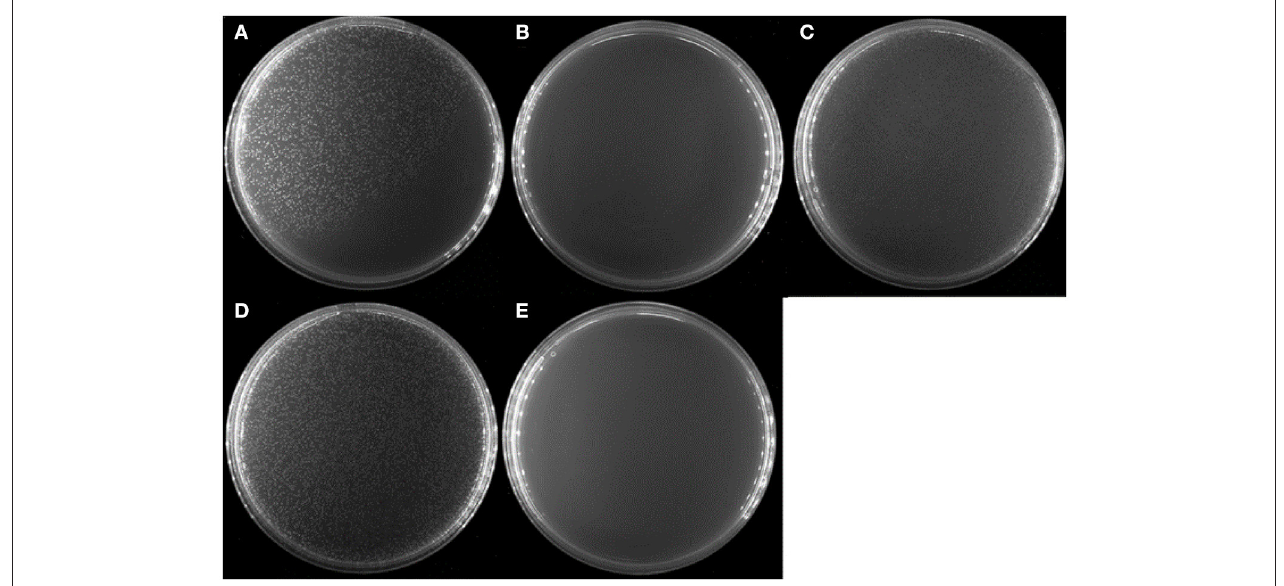
FIGURE 3 | Persister cells wake up on amino acids combination plate agar. V. splendidus persister cells were incubated at 28 ◦ C for 96h on M9 minimal plate agar with four different amino acid combinations, respectively: (A) #1: Phe, Ala, Cys, Ser, and Arg; (B) #2: Tyr, Val, Gly, Thr, and His; (C) #3: Trp, Ile, Pro, Asn, and Lys; (D) #4: Met, Leu, Gln, Glu, and Asp; (E) without amino acid. All amino acids in the experiment were 5 × concentration as listed in Table 1